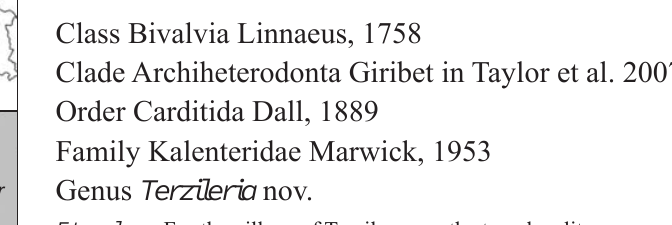
Fig. 2. The kalenterid bivalve Terzileria gregaria gen. et sp. nov. from the late Carnian, Late Triassic Terziler III seep deposit in southern Turkey. A . Mo184051, holotype, internal mold, left valve (A 1 ), dorsal (A 2 ) and anterior (A 3 ) views. B . Mo184052, paratype, specimen with shell partially pre- served, left valve (B 1 ), dorsal (B 2 ) and anterior (B 3 ) views. C . Mo184053, paratype, small specimen with shell preserved on most of posterior side, left valve (C 1 ), the same at slightly different angle (C 2 ), dorsal view (C 3 ). D . Mo184054, fragmentary but articulated specimen, interior of the dorsal side, showing the edentulous hinge. E . Mo184055, paratype, large specimen showing outer shell surface of the anterior half of the shell; left valve (E 1 ) and dorsal view (E 2